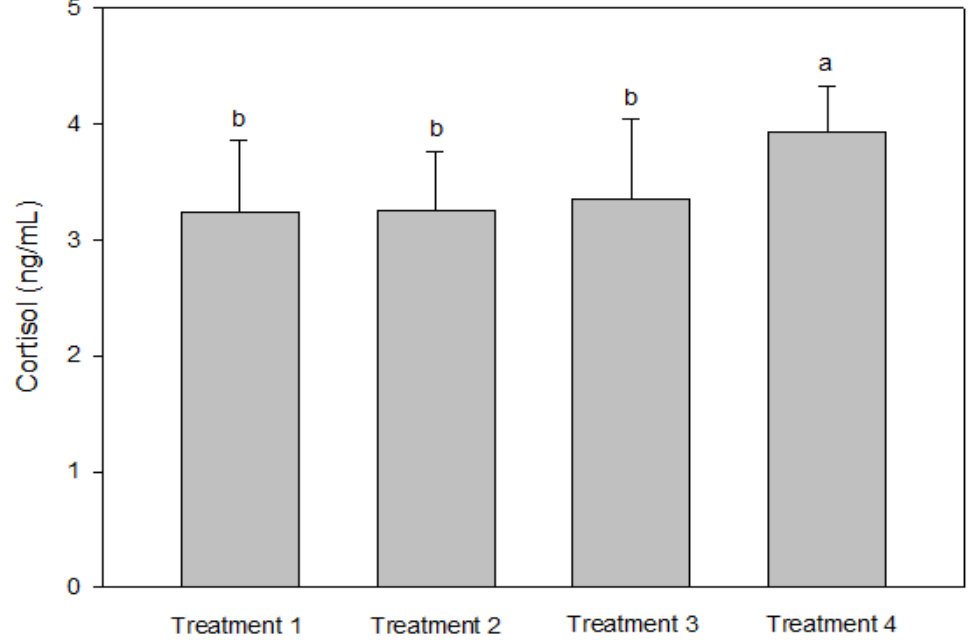
Figure 3. Cortisol levels of olive flounder Paralichthys olivaceus cultured at four different initial stocking densities. The data are presented as mean ± standard deviation. (Small letters “a, b” indicate a significant statistical difference between the treatments.)